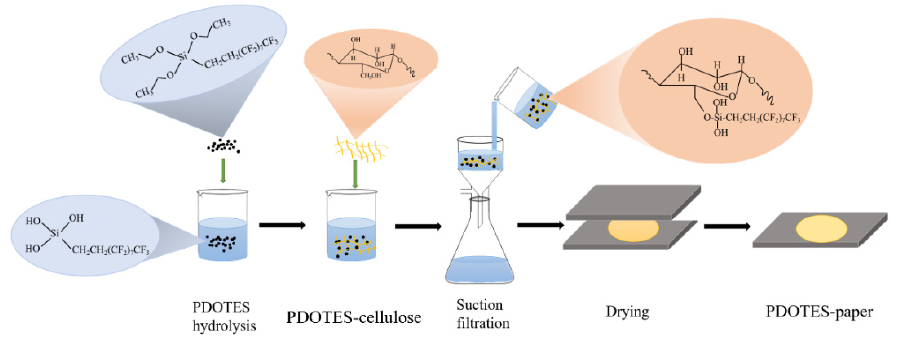
Figure 1. Preparation of PDOTES-paper.